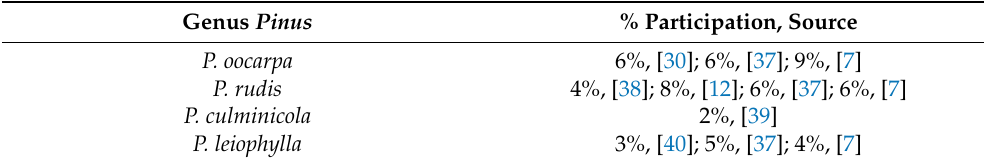
Table 7. Contribution of the four pine species to the national timber production of the genus Pinus according to different authors.